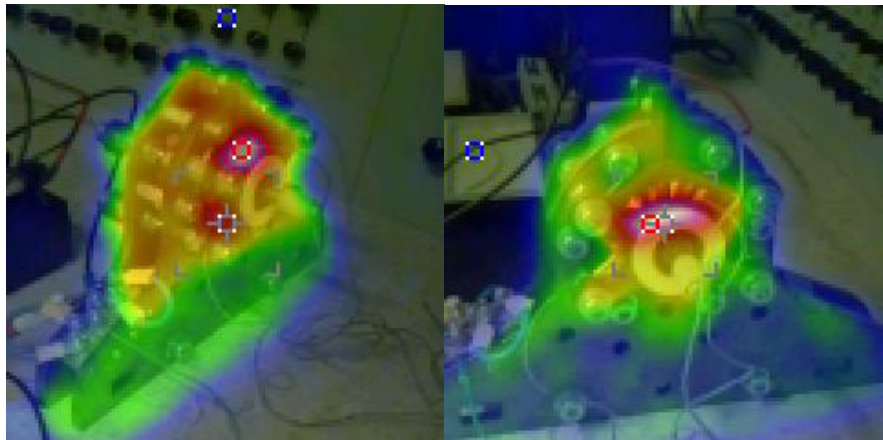
Figure 10. Non-contact measurement of the machine temperature by the thermal camera during the non-rotating tests loaded by DC (nominal current).